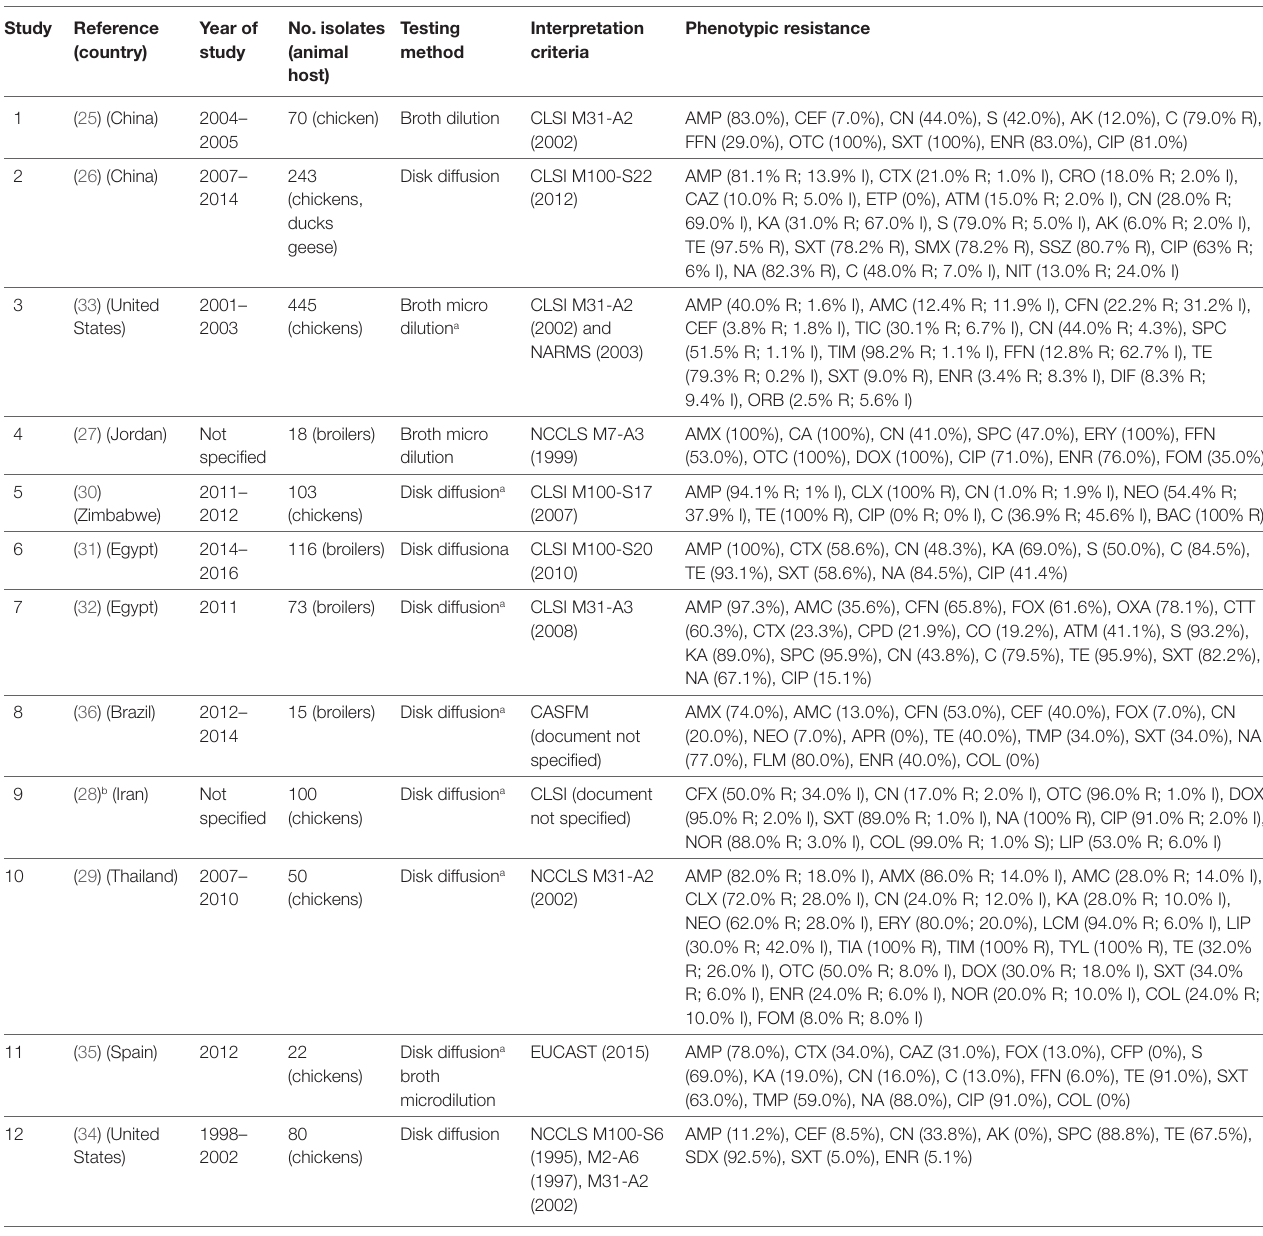
TABLe 1 | Summary of results of 12 phenotypic studies on antimicrobial resistance of avian pathogenic E. coli . Study Reference